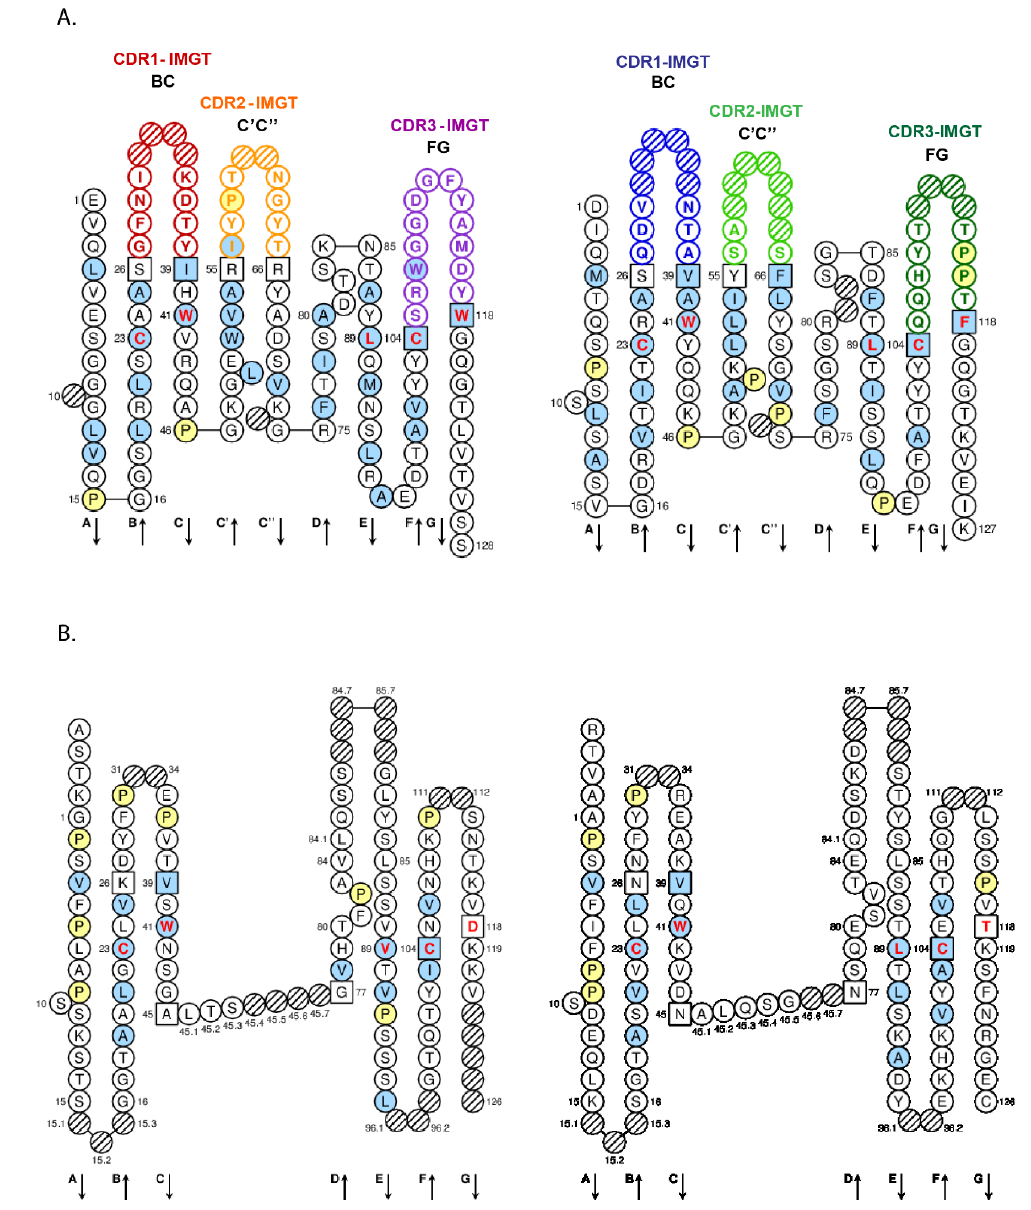
Figure 20. IMGT Collier de Perles of IG V ‐ DOMAIN and C ‐ DOMAIN on one layer [40–42]. ( A ) Trastuzumab VH (on the left) and V ‐ KAPPA (on the right). The CDR1 ‐ IMGT, CDR2 ‐ IMGT and CDR3 ‐ IMGT (corresponding to the BC, C’C” and FG loops, respectively) are represented online in red, orange and purple, for the VH and in blue, green and bluegreen, for the VL (V ‐ KAPPA (here) or V ‐ LAMBDA). The CDR ‐ IMGT lengths are [8.8.13] for VH and [6.3.9] for V ‐ KAPPA ( B ) Trastuzumab CH1 (on the left) and C ‐ KAPPA (on the right). Amino acids are shown in the one ‐ letter abbreviation. Positions at which hydrophobic amino acids (hydropathy index with positive value: I, V, L, F, C, M, A) and tryptophan (W) are found in more than 50% of analysed sequences are shown online in blue. All proline (P) are shown online in yellow. Hatched circles correspond to missing positions according to the IMGT unique numbering for V domain [40,41] or C domain [42]. Arrows indicate the direction of the beta strands and their designations in 3D structures. Anchors are shown in squares. (With permission from M ‐ P. Lefranc and G. Lefranc, LIGM, Founders and Authors of IMGT ® , the international ImMunoGeneTics information system ® , http://www.imgt.org).